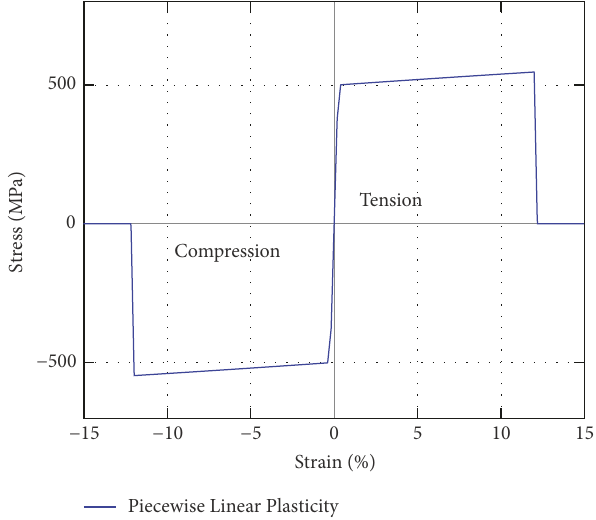
Figure 5: Stress-strain diagram for 500 MPa yield stress Piecewise Linear Plasticity material model.